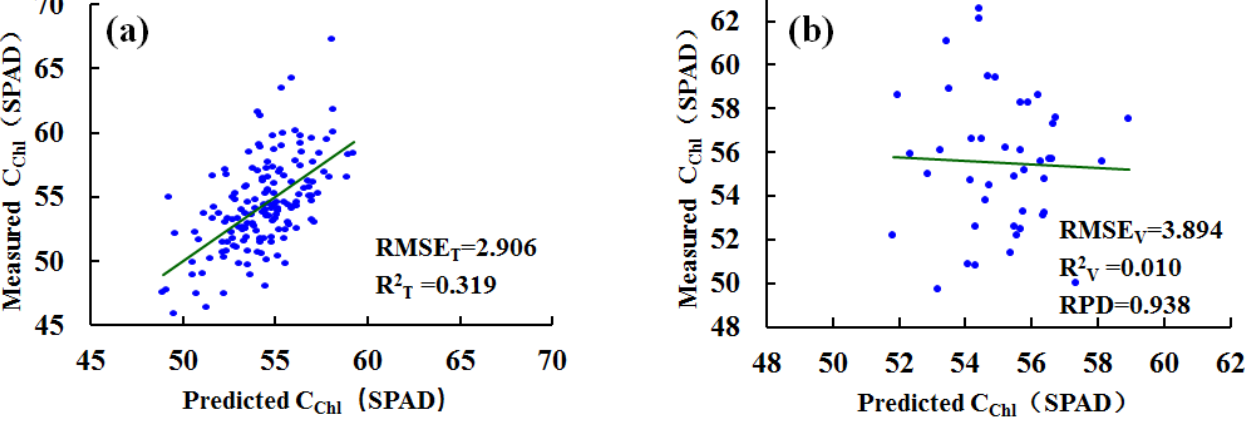
Figure 4. The estimated results of SPAD value for ( a ) training set and ( b ) validation set at heading stage.